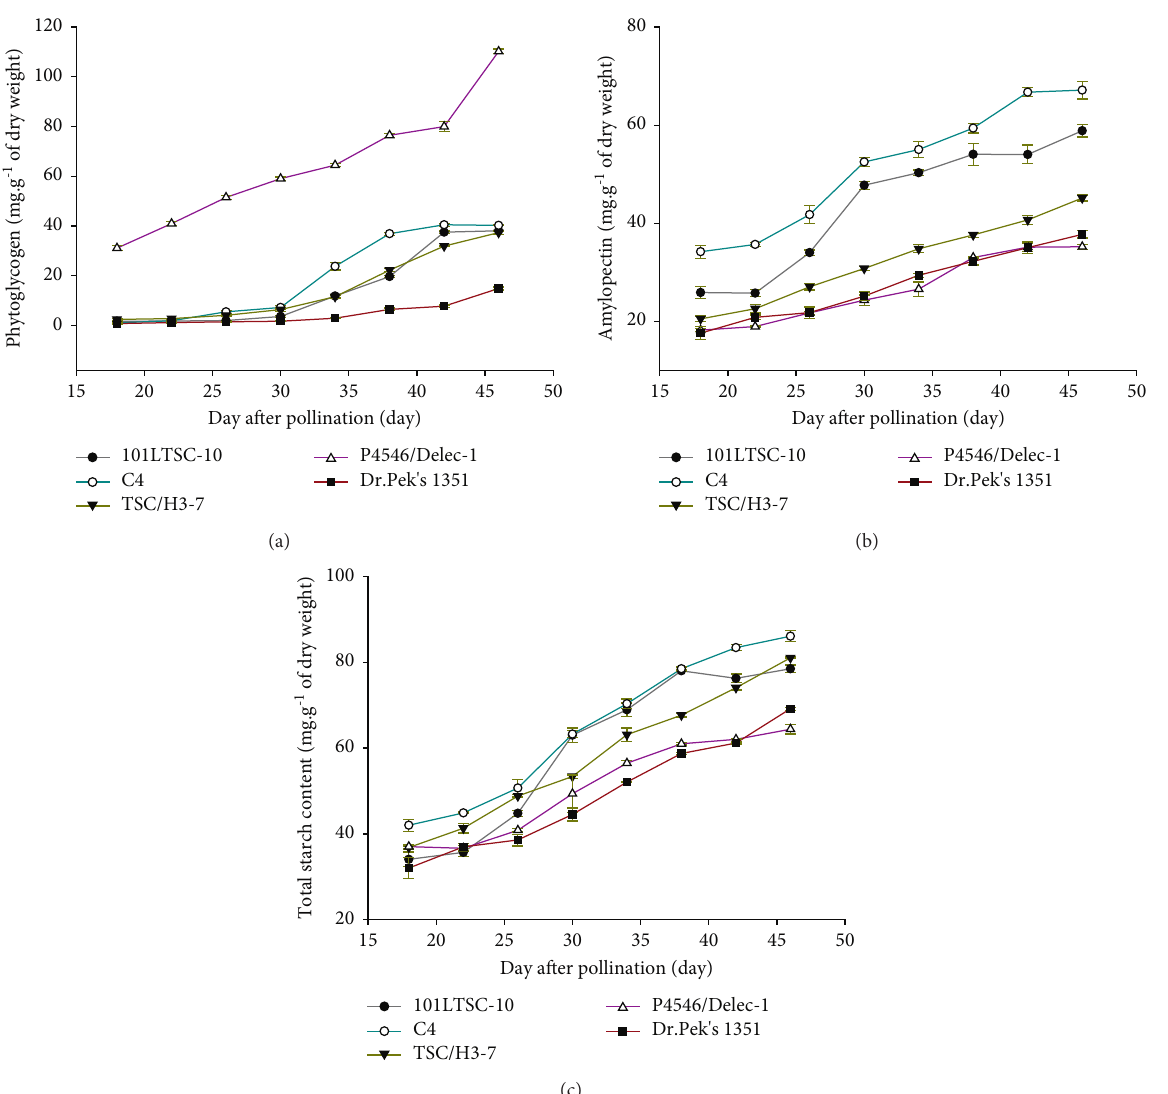
Figure 4: The changes of starch contents in sweet corn seeds during seed development: (a) phytoglycogen, (b) amylopectin, and (c) total starch content. The data are means of four replicate samples and error bar ± SD ( n �